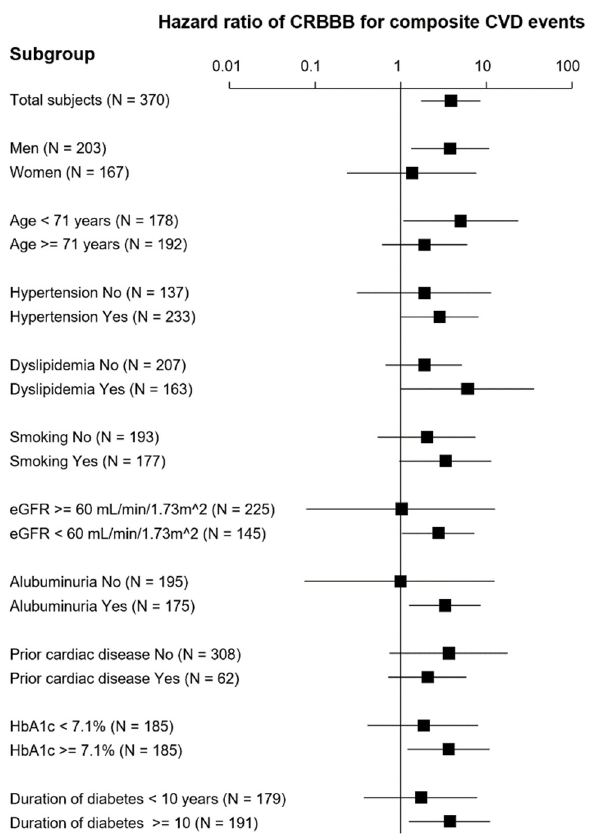
Figure 3. Stratified analysis of the association of CRBBB with cardiovascular events. The figure gives hazard ratios and 95% confidence intervals for each group by IPTW-adjusted Fine–Gray